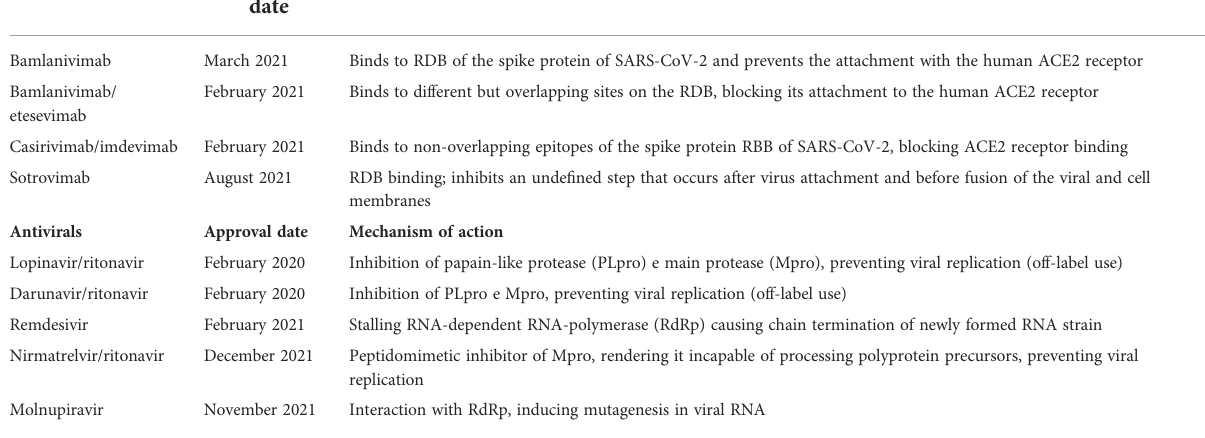
TABLE 1 Mechanism of action of mabs and